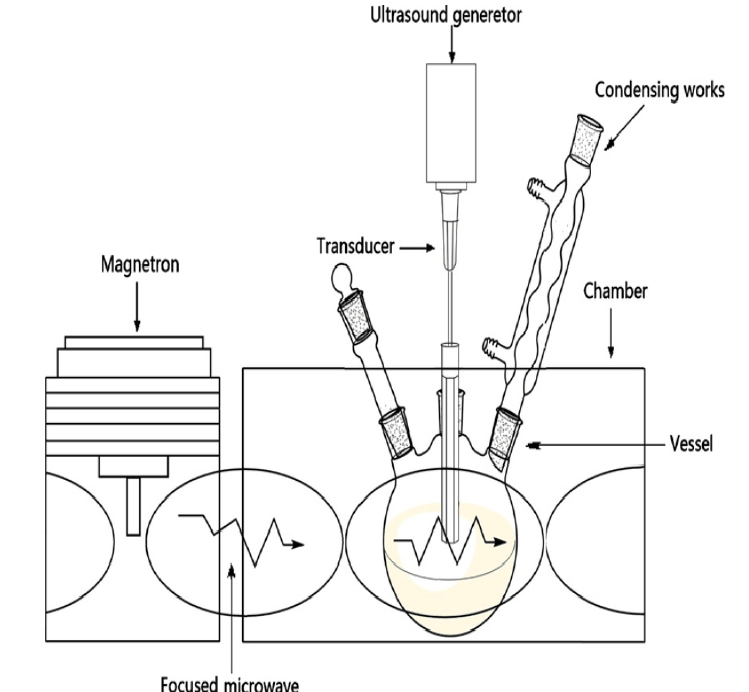
Figure 2. Schematic diagram of an apparatus for ultrasonic-microwave assisted extraction (UMAE)